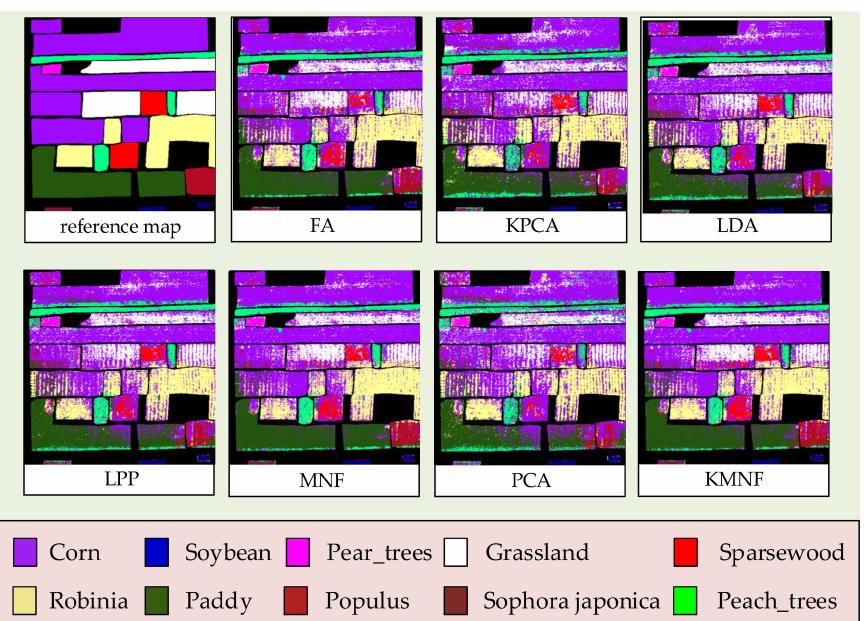
Figure 5. The results of SVM classifier for Xiong’an after each feature extraction method (number of features = 45).